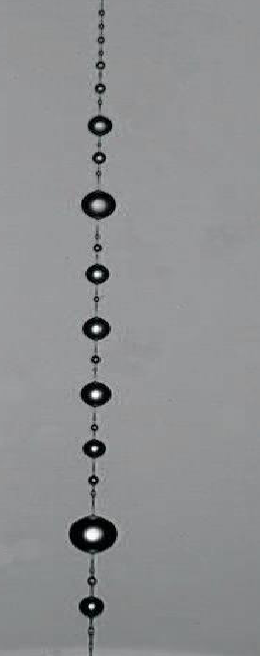
Figure 31. Heterogeneous stretching: necking ( a ) and gradual contraction ( b ).